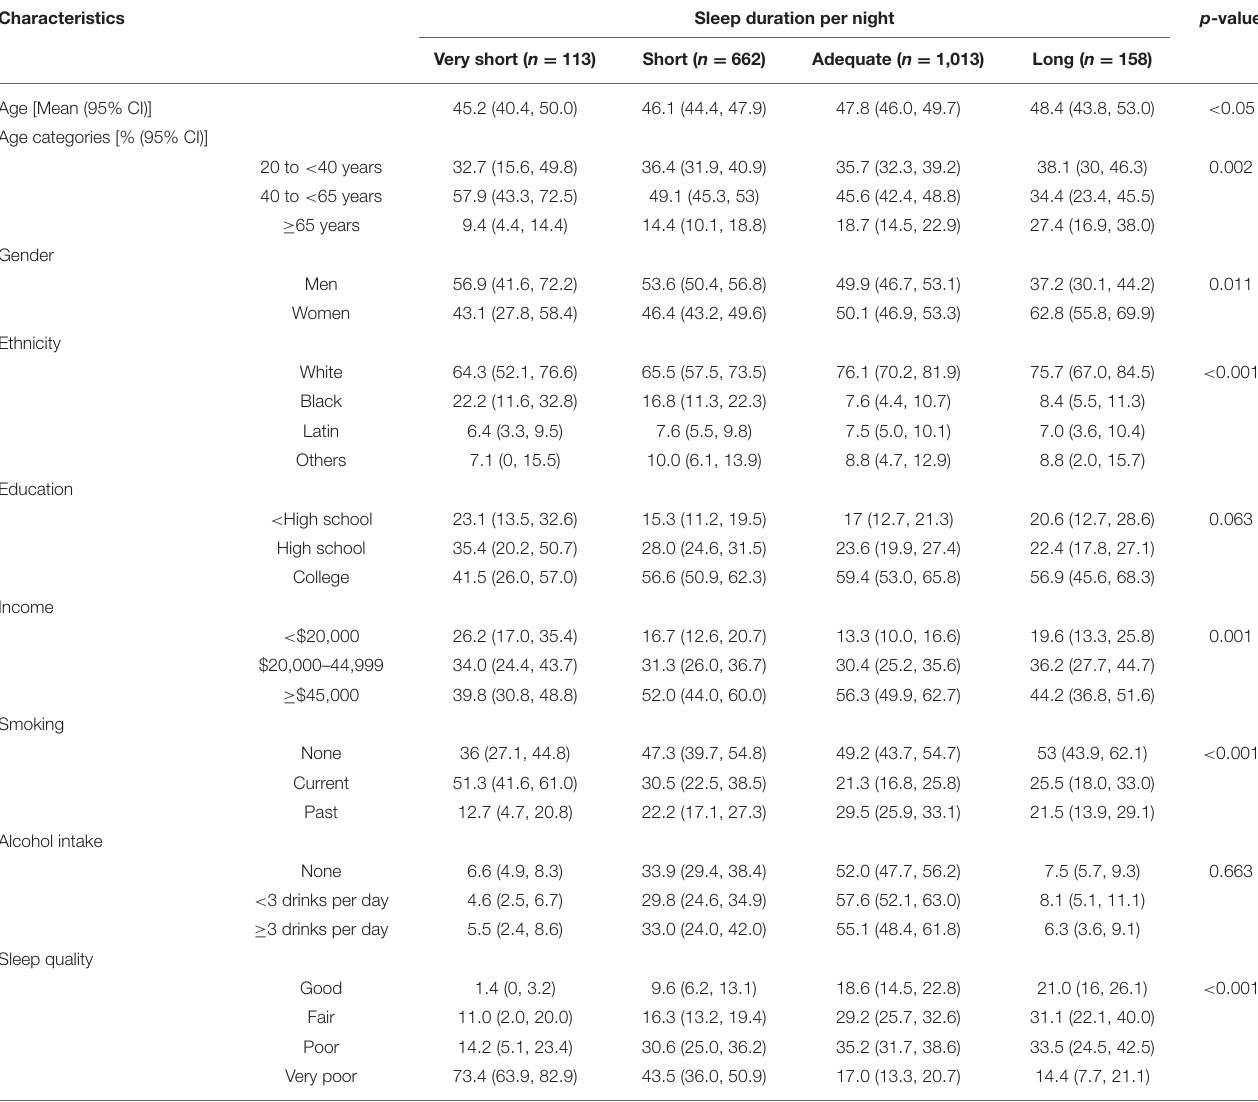
TABLE 1 | Characteristics of the US adult population ≥ 20 years of age by sleep duration. Characteristics